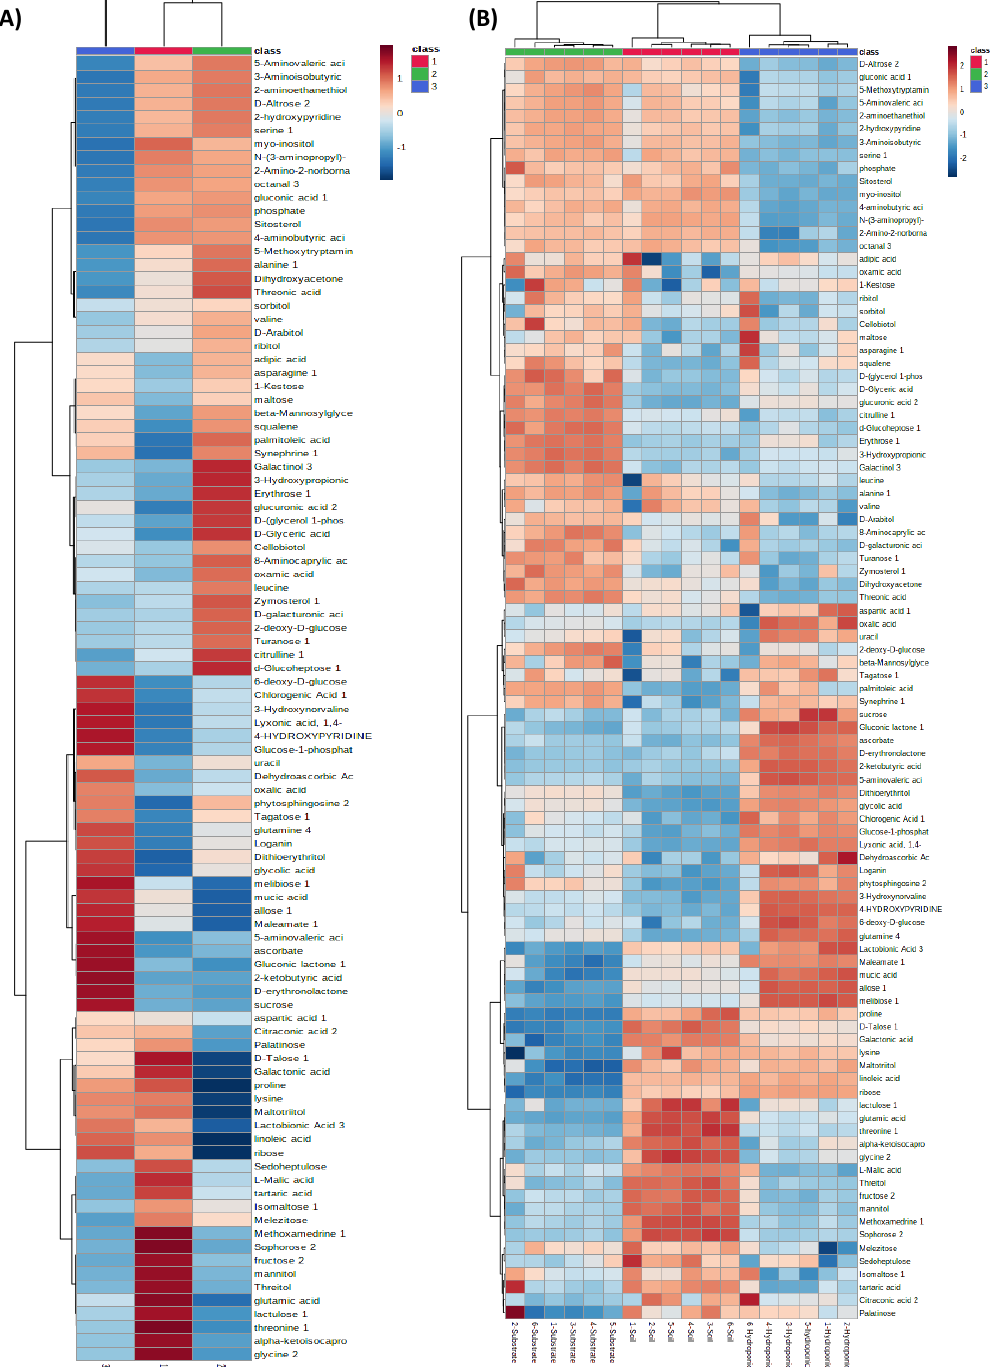
Figure 11. Heat map of different metabolites in soil-, substrate- and hydroponically grown lettuce. Note- Left-side ( A ) shows up- and down-regulation of metabolites in metabolomic profiles of lettuce in soil, substrate and hydroponic cultivation systems by combining means of all different applied NH 4+ /NO 3 − ratios (100:0, 75:25, 50:50, 25:75 and 0:100%) and control (no additional N applied) in hydroponic, soil, and substrate cultivation systems. Right-side ( B ) shows variation in up- and down- regulation of metabolites in metabolomic profiles of lettuce by various applied NH 4 + /NO 3 − ratios (100:0, 75:25, 50:50, 25:7 and, 0:100%) and control (no additional N applied) in hydroponic, soil, and substrate cultivation systems. Red color represents soil-grown lettuce metabolites, green color represents substrate-grown lettuce metabolites and blue color represents hydroponically grown lettuce